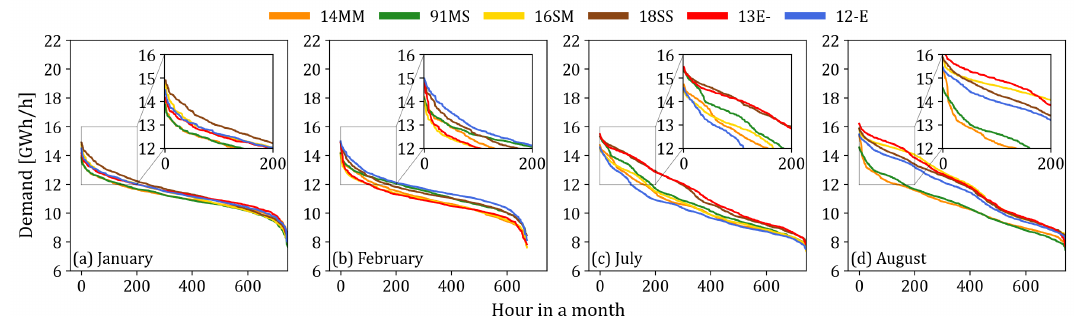
Figure 10. Monthly duration curve of the synthetic demand.